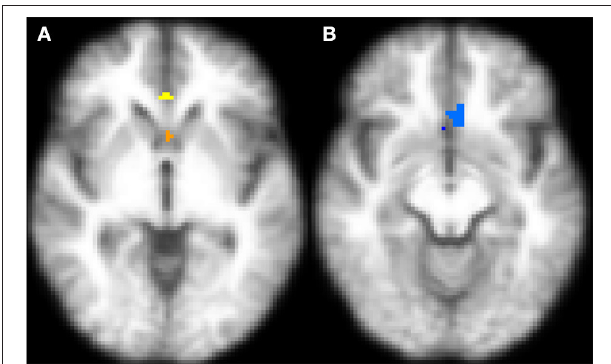
FIGURE 5 | Transverse sections of the brain depicting regions within the mPFC that showed a post- vs. pre-TC intervention increase in rs-fMRI connectivity in with the (A) left amygdala (orange-yellow) and (B) right amygdala (64) after 8-week TC intervention. The functional maps have been registered on the mean of T1-weighted structural images of all participants. An increase in rs-fMRI connectivity was observed between bilateral mPFC and the left amygdala [ n = 7, p = 0.355, (A) ] and right amygdala [ n = 7, p = 0.282; (B) ] seed regions with 8 weeks of TC intervention. The images represent within-subject pre-post comparisons. After correcting to maintain family-wise error rate at 0.05, none of the observed changes remained statistically